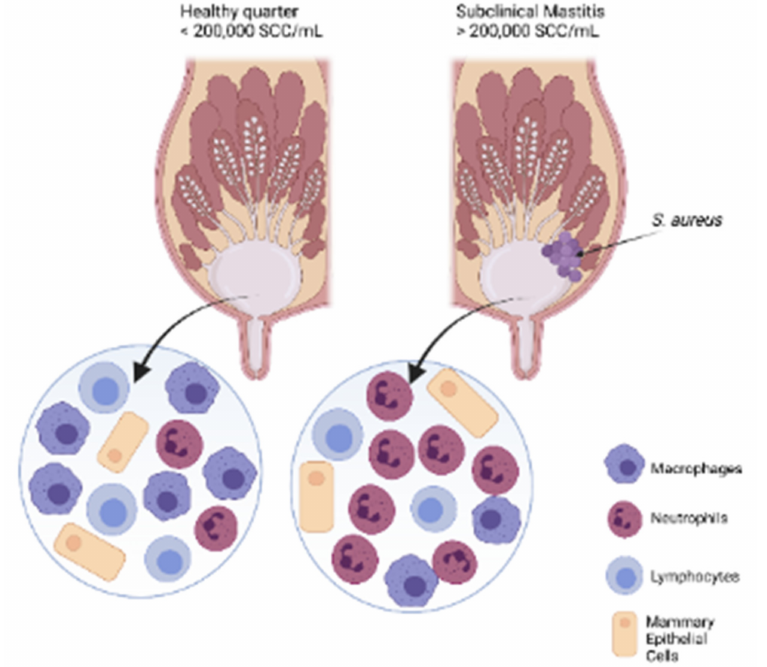
Figure 2. Presence of somatic cells in healthy and infected quarters of a cow. In the milk of a healthy quarter there are present more macrophages, followed by a small percentage of lymphocytes, neutrophils, and epithelial cells, whereas an infected quarter, with clinical mastitis or subclinical mastitis, is overpopulated with neutrophils and few macrophages, lymphocytes, and epithilail